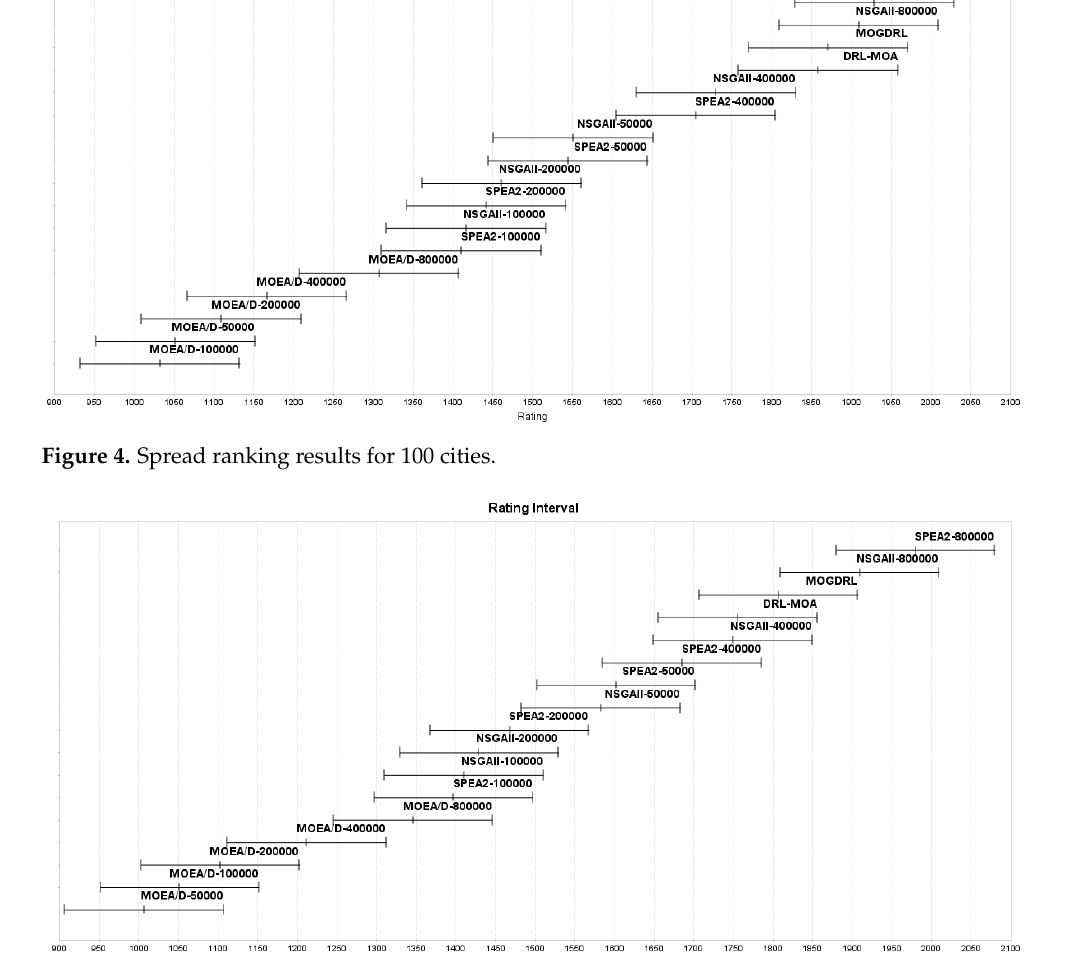
Figure 5. CPF ranking results for 100